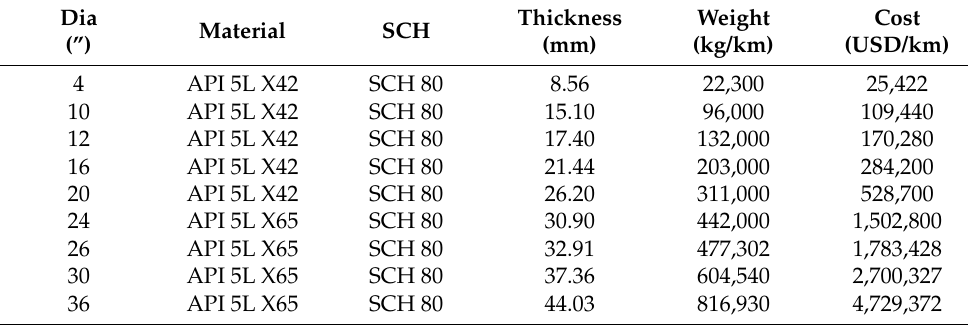
Table 2. Specifications of natural gas main pipelines by diameter in Korea.